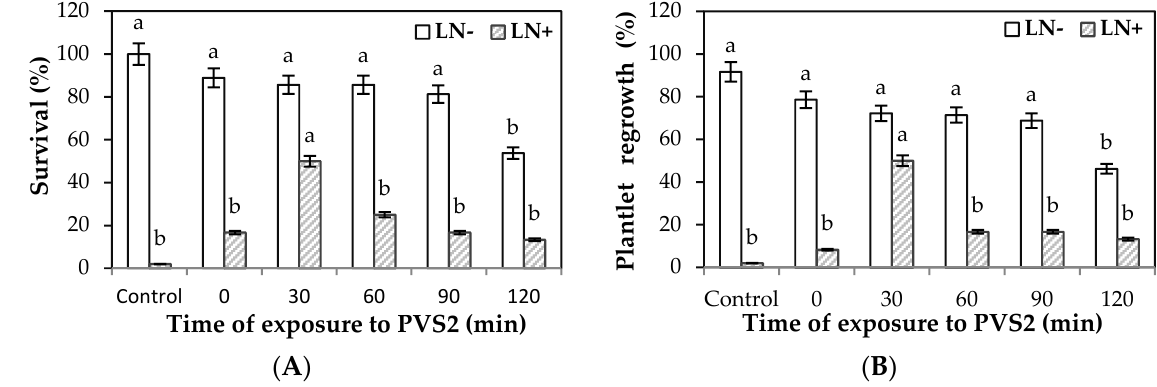
Figure 1 . Percentages of survival ( A ) and plantlet regrowth ( B ) of encapsulated Castanea sativa embryonic axes (EAs) after exposure to Plant Vitrification Solution 2 (PVS2) for increasing times, with (LN+) or without (LN − ) subsequent immersion in liquid nitrogen. EAs were encapsulated in WPM medium containing 2.5% ( w / v ) sodium alginate. Encapsulated EAs were treated for 60 min with a loading solution (2.0 M glycerol, 0.4 M sucrose), followed by treatment with PVS2 at 0 °C for 30–120 min, prior to direct immersion in LN for 1 h. Control EAs received no LS and PVS2 treatments. Within each line (LN − and LN+), data followed by different letters are significantly different at p ≤ 0.05 by LSD test (bars, SE of means).